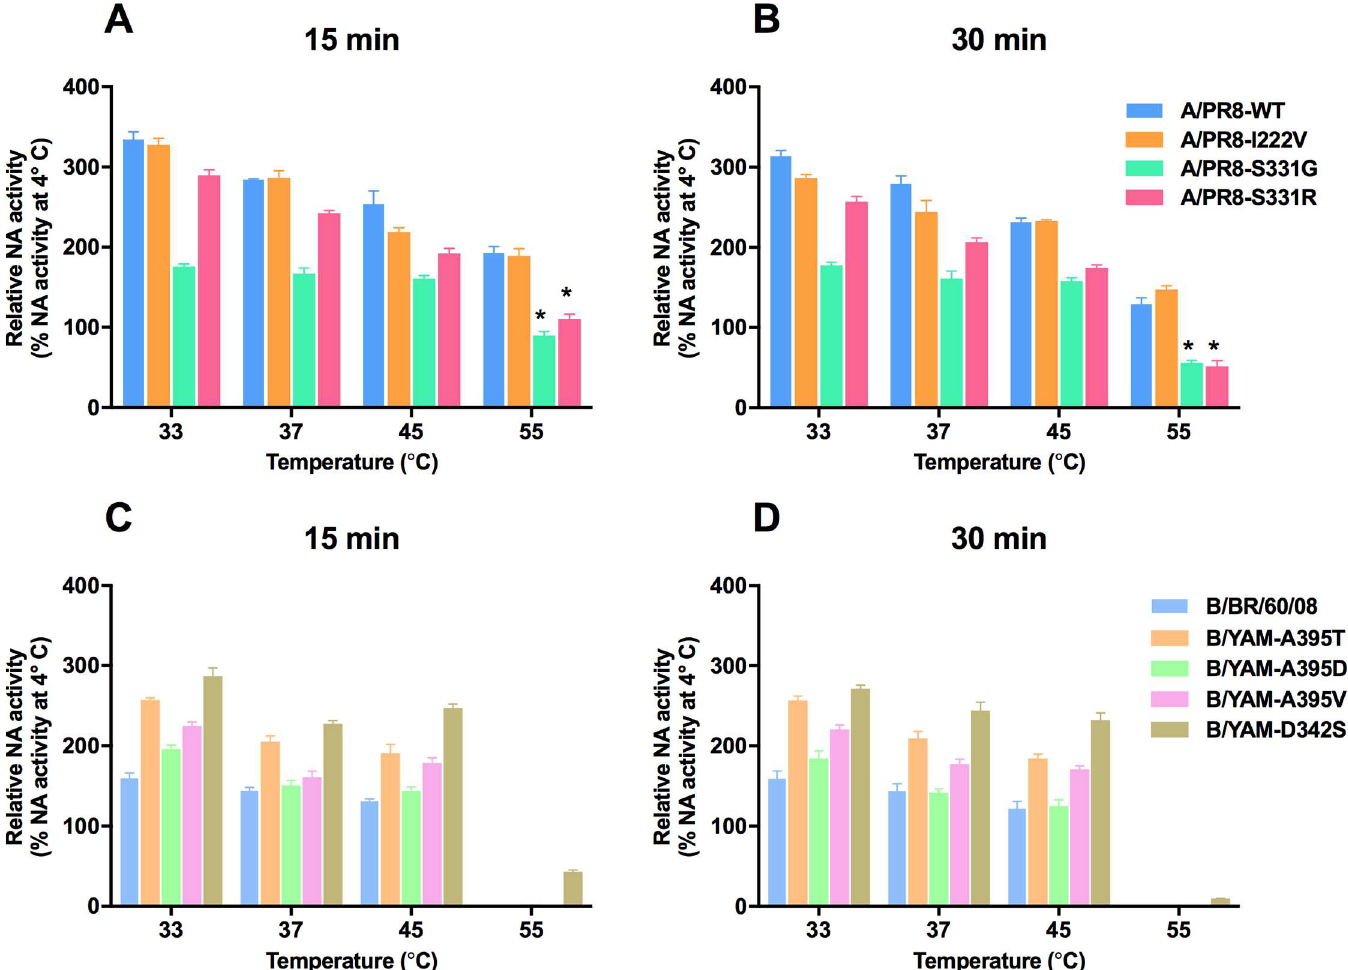
Fig 1. The NA thermostability of the recombinant influenza A and B viruses carrying a single NA substitution. Influenza A/PR8 (A, B) and B/YAM (C, D) viruses were incubated for 15 or 30 min at the indicated temperatures. Residual NA enzyme activity was assayed and is presented as a percentage of the NA activity at 4˚C (unheated). The bars represent the mean of the relative NA activity ± SD for different temperatures from three experiments. (cid:3) P < 0.05.